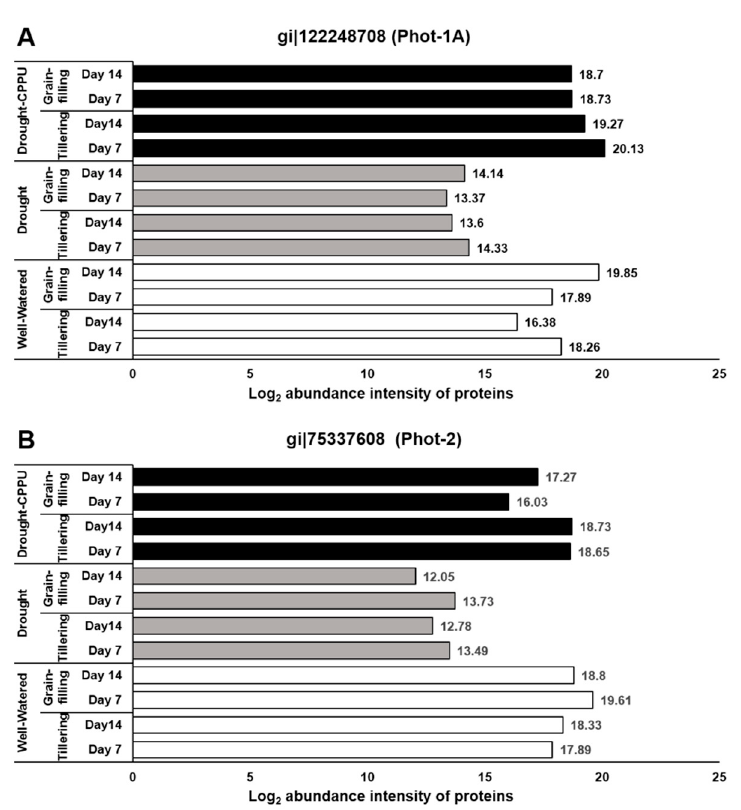
Figure 5. The influence of synthetic cytokinin and drought on the abundance intensities of phototropins, Phot-1 ( A ), and Phot-2 ( B ) proteins, implicated in photosynthesis and stomatal conductance at tillering and grain-filling stages of the rice. Protein abundance intensities, represented on the X- axis, are the highest log2 fold change values of technical replicates. [Well-Watered plants were maintained at a soil moisture tension of − 15 kPa during the treatment period. Drought stress was imposed by withholding water for up to 14 days. Soil moisture tensions of − 55 kPa and − 72 kPa were recorded at day 7 and day 14 during the treatment, respectively. CPPU treatment was given by foliar spraying plants with a 5 mg / L solution of CPPU at the rate of 25 mL / plant on day 6 of drought treatment.